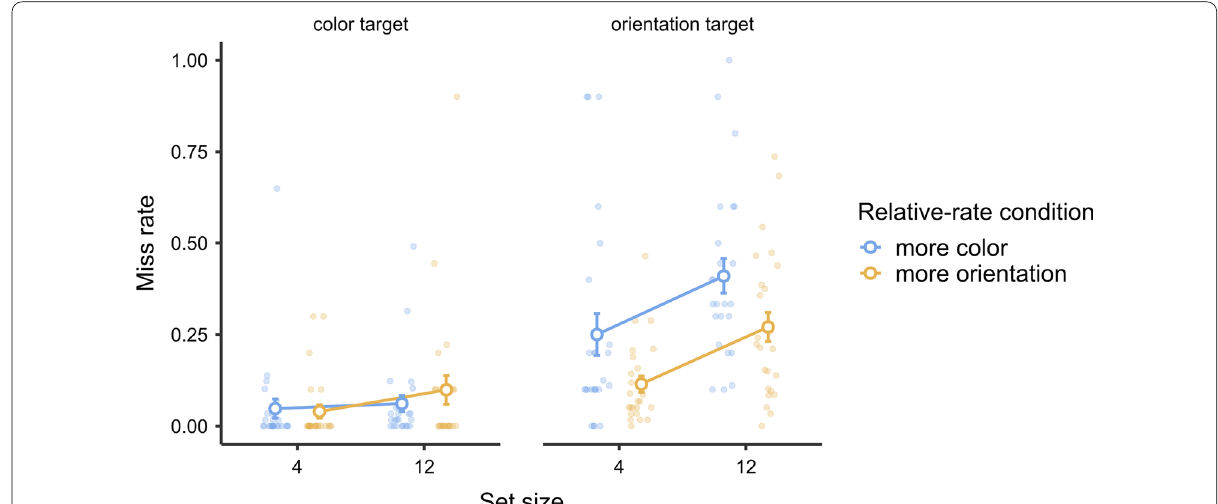
Fig. 7 Experiment 3 results: miss rate. Note In Experiment 3, relative target-rate effects occurred in terms of miss rates for orientation targets only. For the color targets, there was an apparent floor effect. There were no relative target-rate effects on search efficiency. Error bars represent standard error of the mean